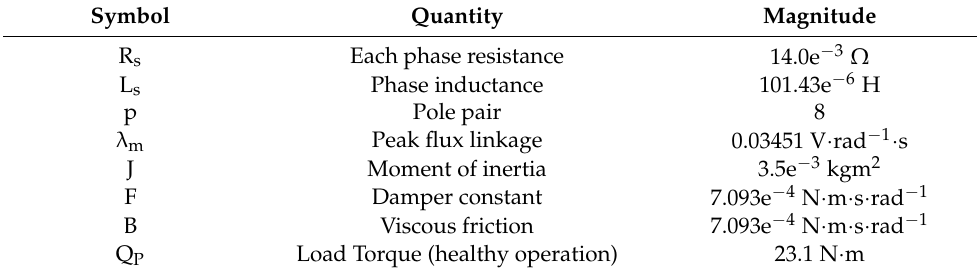
Figure 10. A simulation model for the fault-tolerant control of the five-phase PMSM. Table 4. Modeling parameters of the five-phase PMSM.